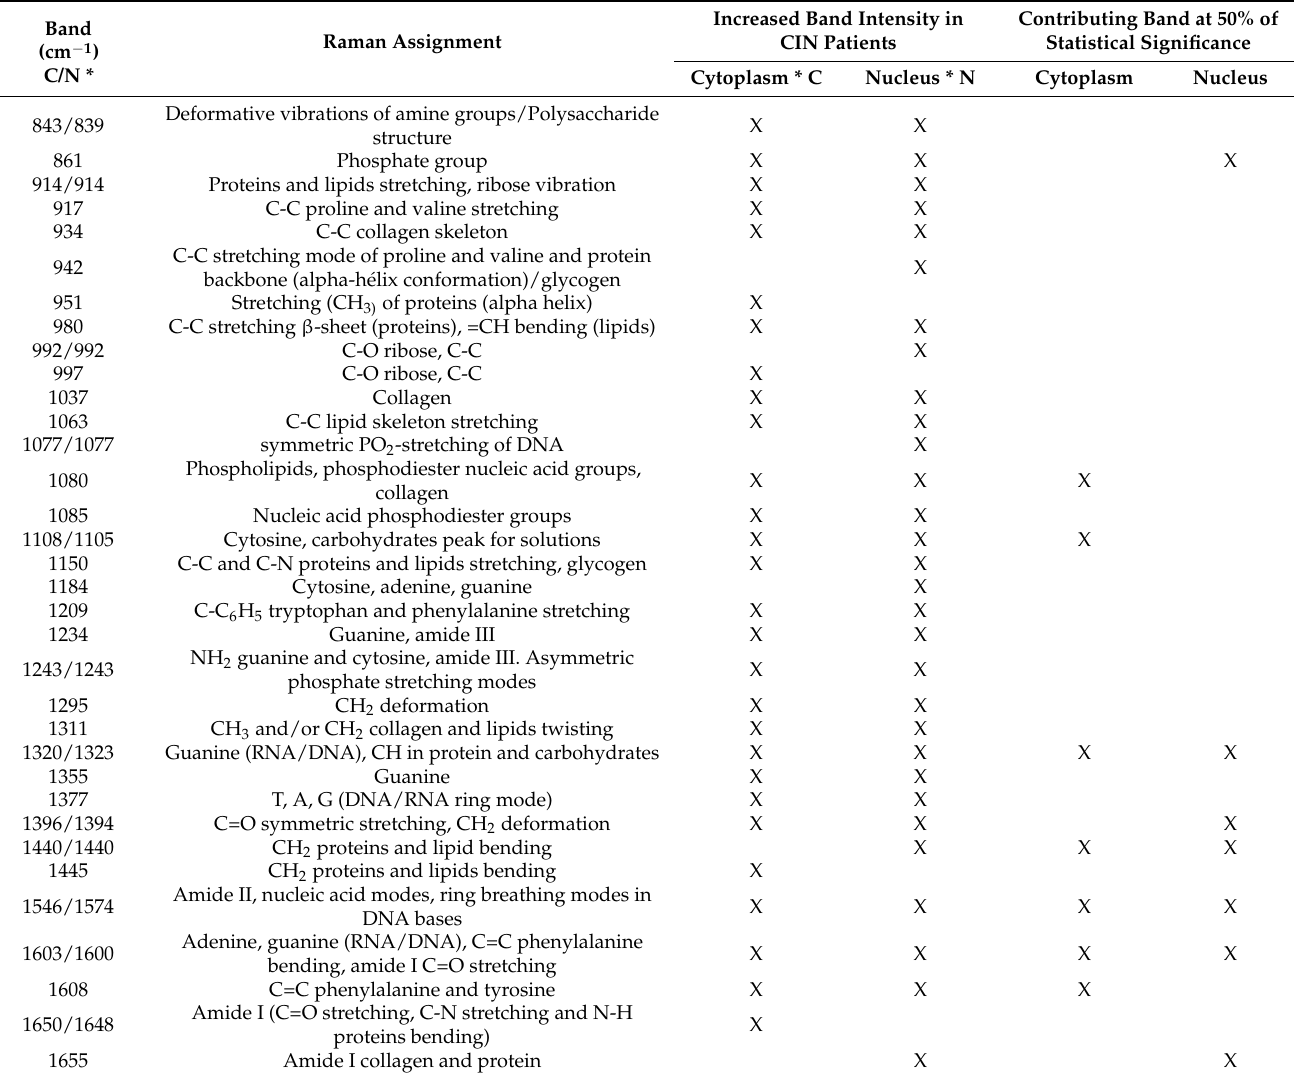
Table 1. Assignments of the Raman spectra of cytoplasm and nucleus of cervical cell